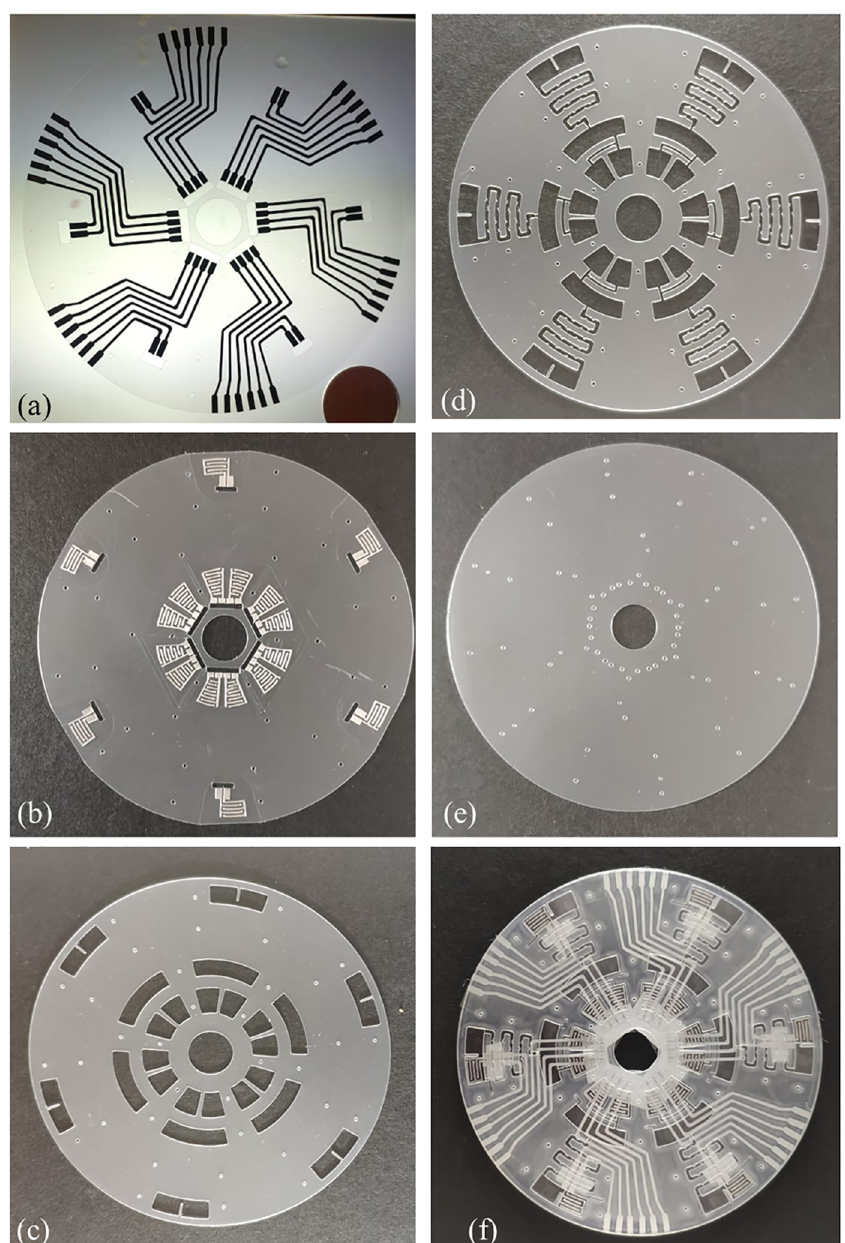
Fig 3. Fabricated microfluidic CD (a) bottom layer with conductive trace, (b) aluminum interdigitated electrode layers, (c) microfluidic chamber layer, (d) layer with microfluidic chambers and channels, (e) top cover layer with fluidic inlet and (f) assembled and bounded microfluidic